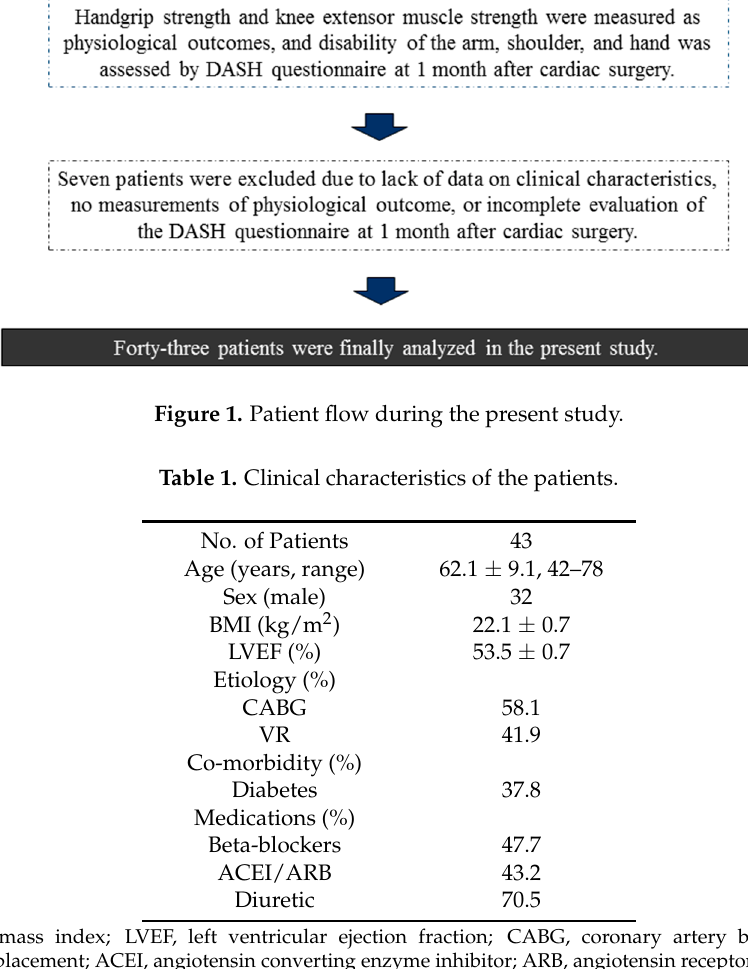
Table 2. Handgrip strength, knee extensor muscle strength, and Disabilities of the Arm, Shoulder, and Hand (DASH) scores of the